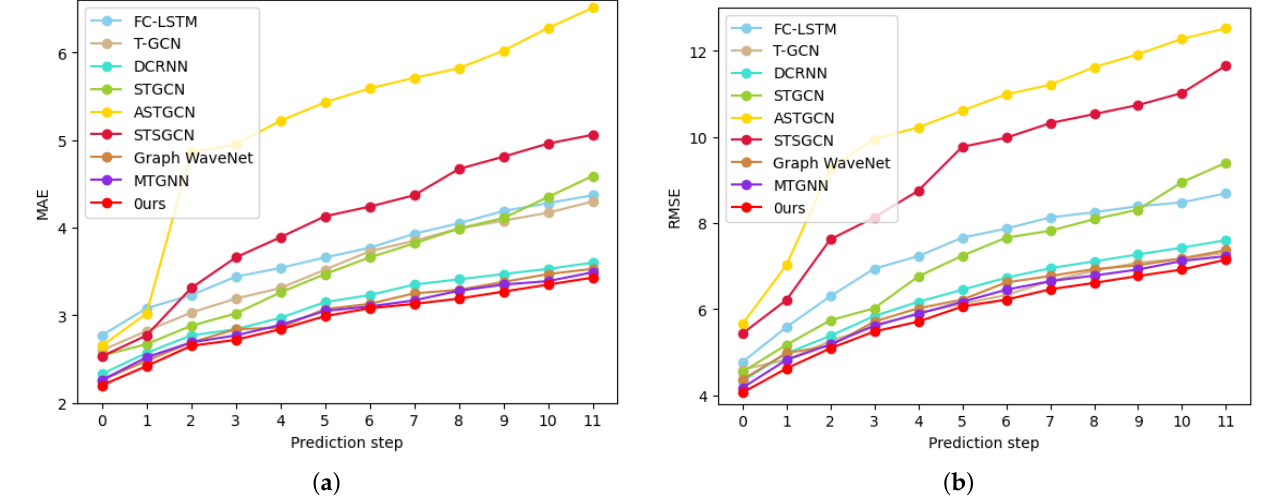
Figure 8. Comparison of each step error of all models on dataset METR-LA: ( a ) MAE; ( b ) RMSE.